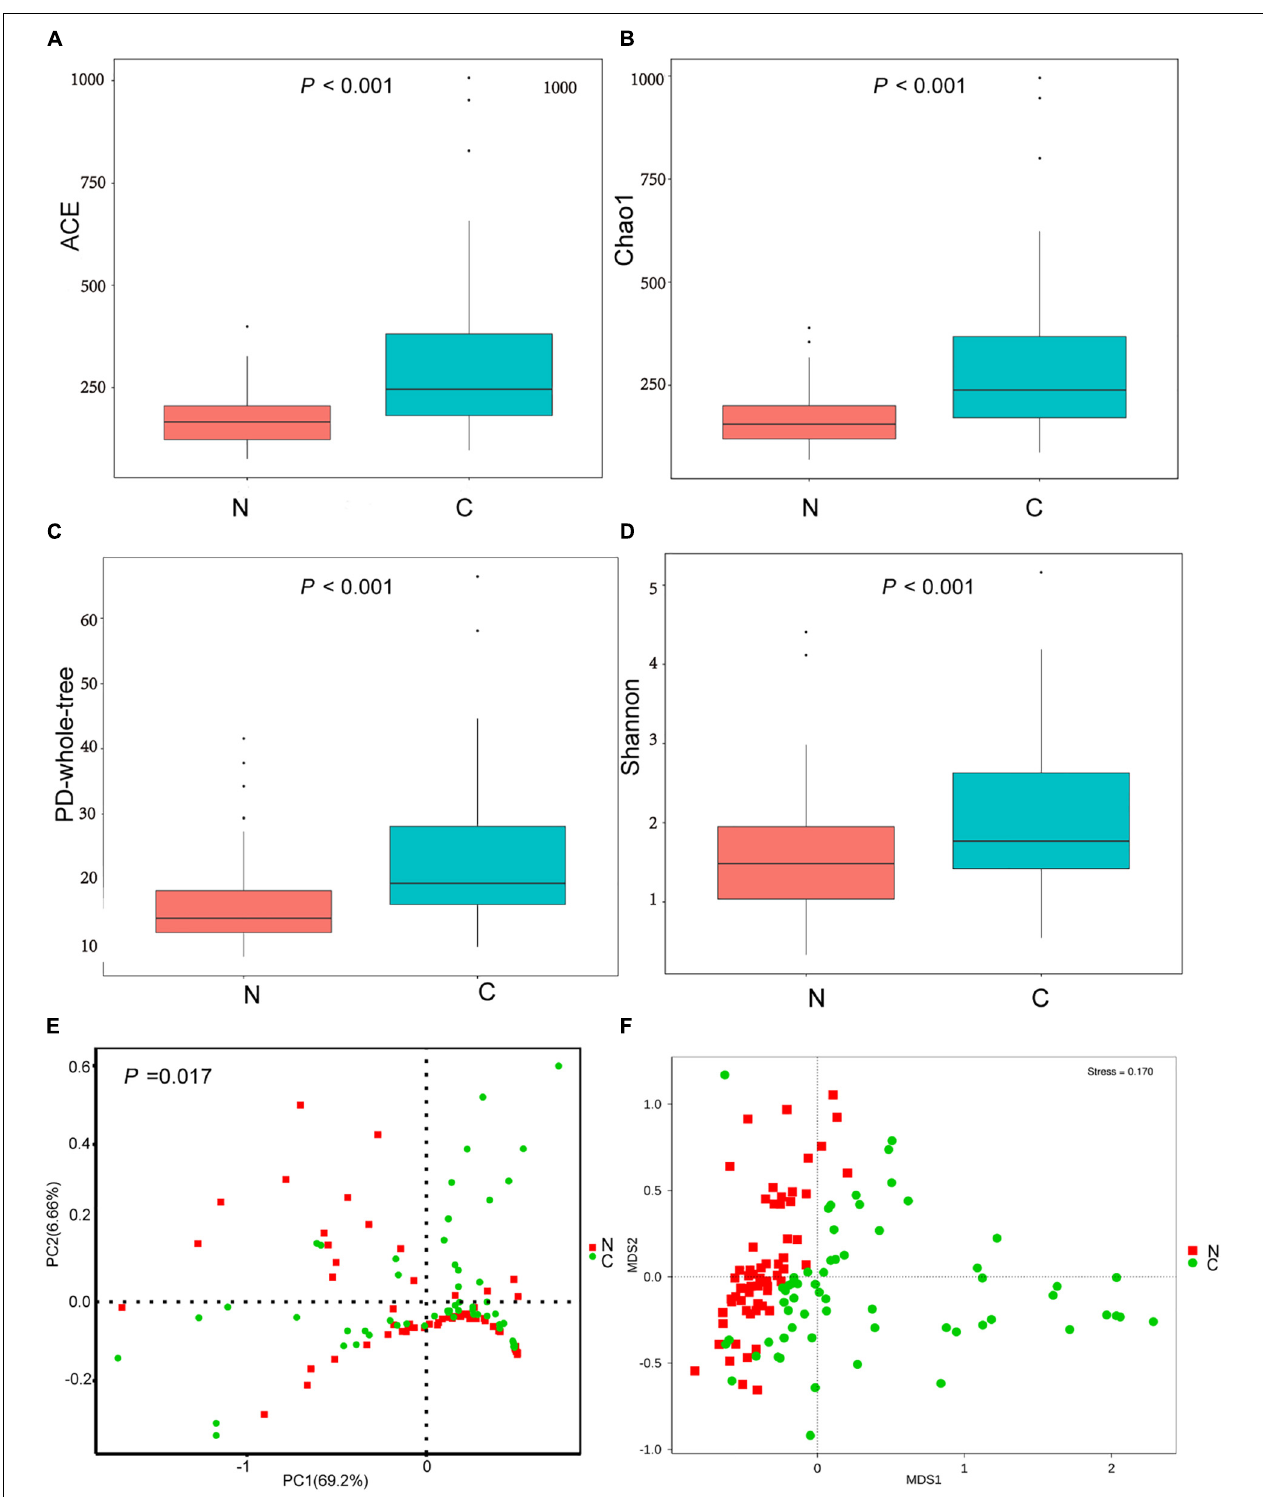
FIGURE 2 | (A–D) The alpha diversity of the microbial communities in cancer and non-cancer groups. The global microbial structure differs between the two groups in (E) PCoA plot and (F) NMDS plot. C, cancer group; N, non-cancer group.